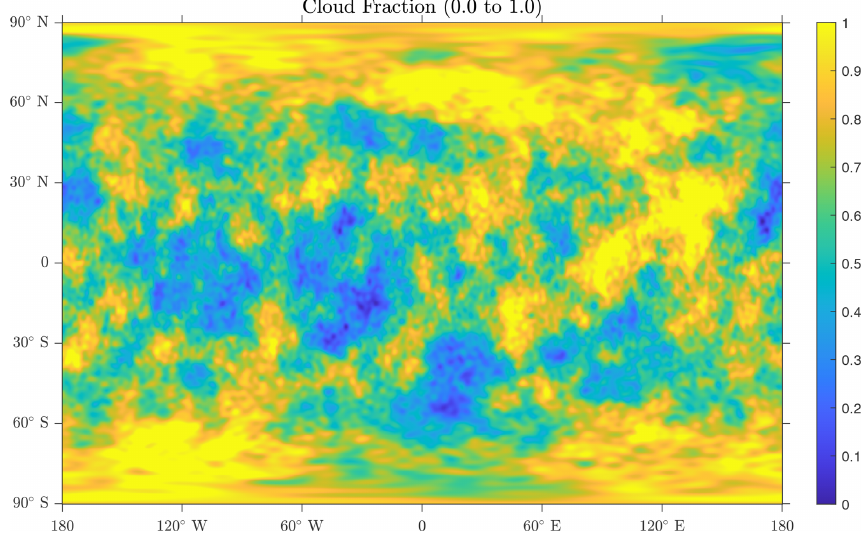
Figure 7. The cloud fraction field used in evaluating the effectiveness of CAAS on a real data field.